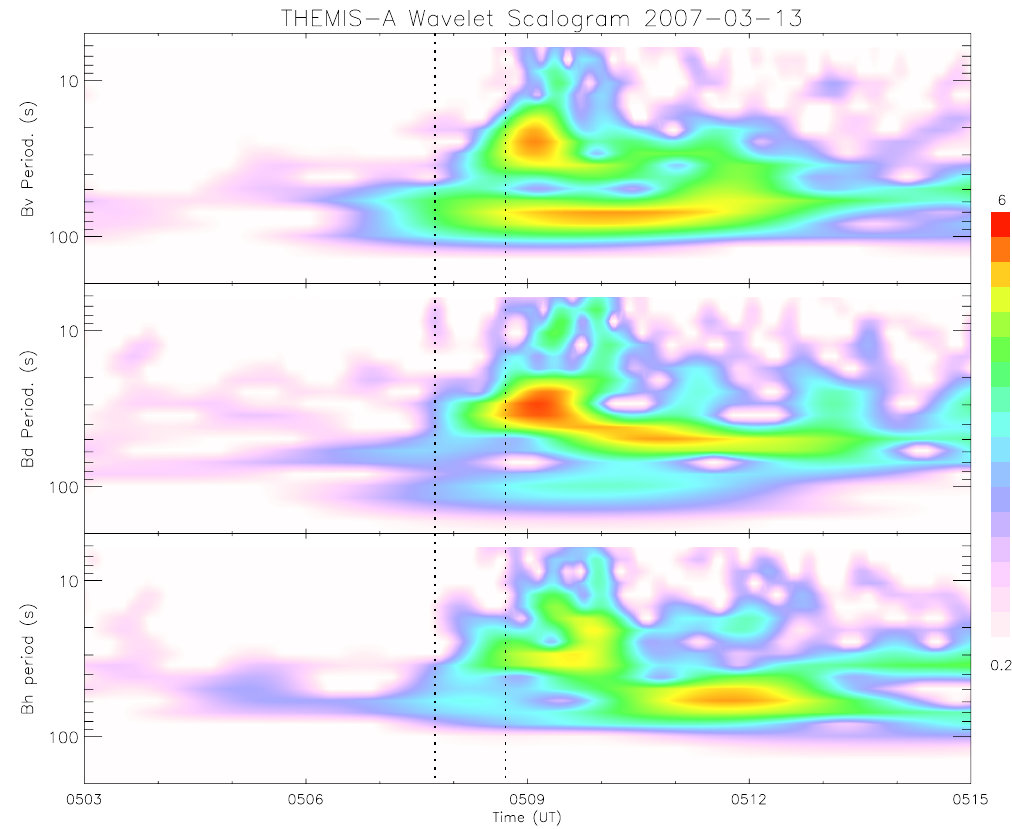
Fig. 3. Wavelet scalogram of the magnetic fields observed on TH-A. Two vertical lines indicate the time of EP onset and local CD onset time,